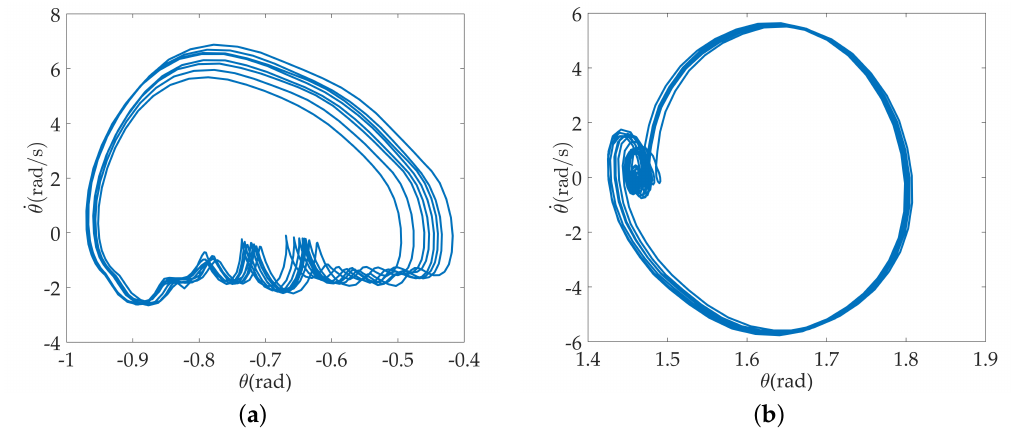
Figure 15. Snapshots of trotting at 0.4 m/s on the physical prototype experiment.